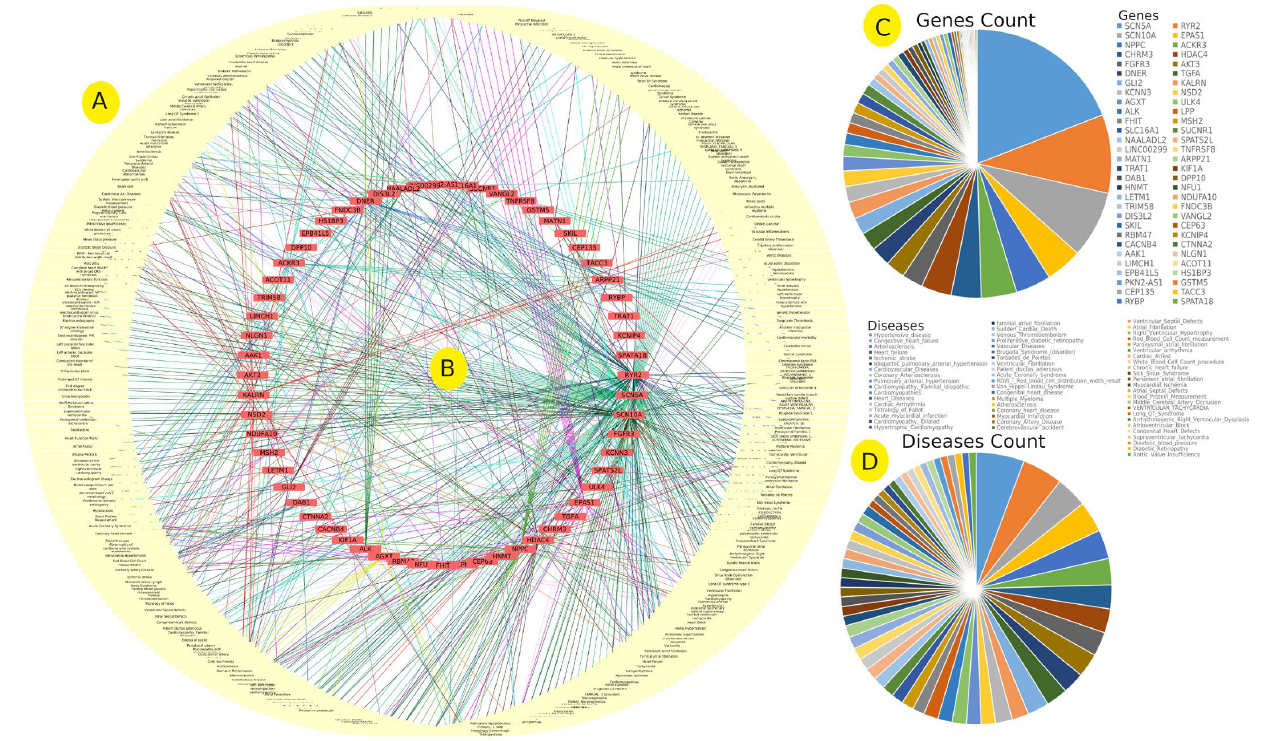
Figure 8. The disease–gene analysis of the cardiovascular disorders ( A ) and genes associated with hypertension ( B ) in the studied Qatari population. The comparison of the presence of various genes ( C ) and disease ( D ).